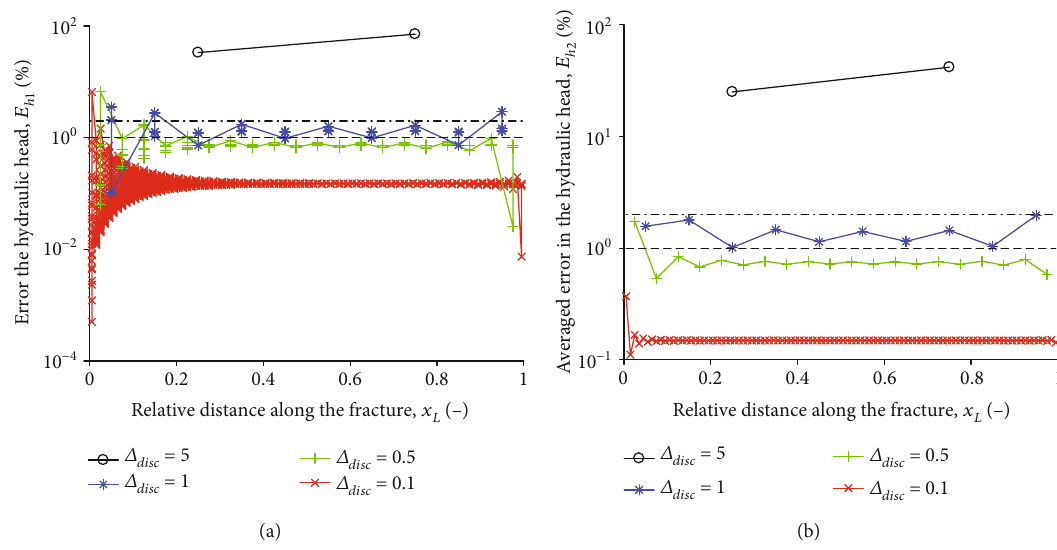
= x / L for the fracture con fi guration Con fi g_1a (Figure 3(a)) with the L at each position ð x , y Þ and (b) the relative h 1